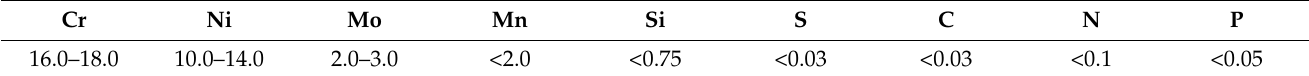
Figure 2. Schematic representing the workflow of the current study (from step a to d). ( a ) Printing of several 316L SS clads by LMD on wrought 316L base plate. ( b ) Analysis of microstructural fea- tures and defects. ( c ) Exposure of the samples to corrosive electrolyte (containing Cl – and Cl – + low pH). ( d ) Corrosion morphology analysis to determine the role of the different defects and micro- structural features.